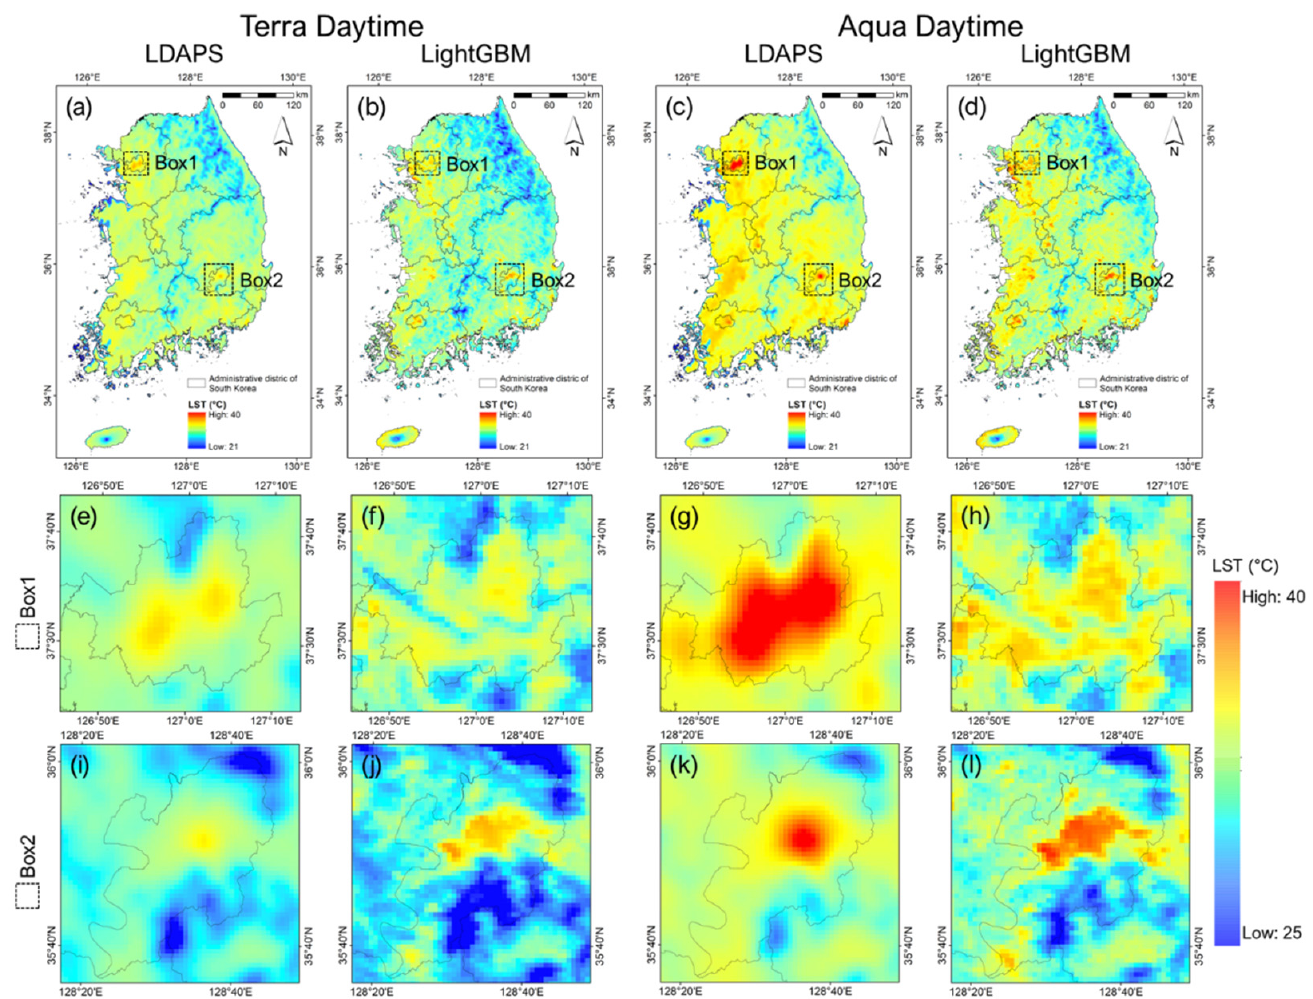
Figure 7. Spatial distribution of the average all-sky 1 km LSTs for Terra and Aqua daytime produced by ( a , c ) LDAPS and ( b , d ) LightGBM in June–August from 2013 to 2020. The enlarged LST distributions of ( e , g , i , k ) LDAPS and LightGBM ( f , h , j , l ) are shown for two subset areas (i.e., boxes 1 and 2), which are representative metropolitan areas in South Korea that often suffer from summer heatwaves.